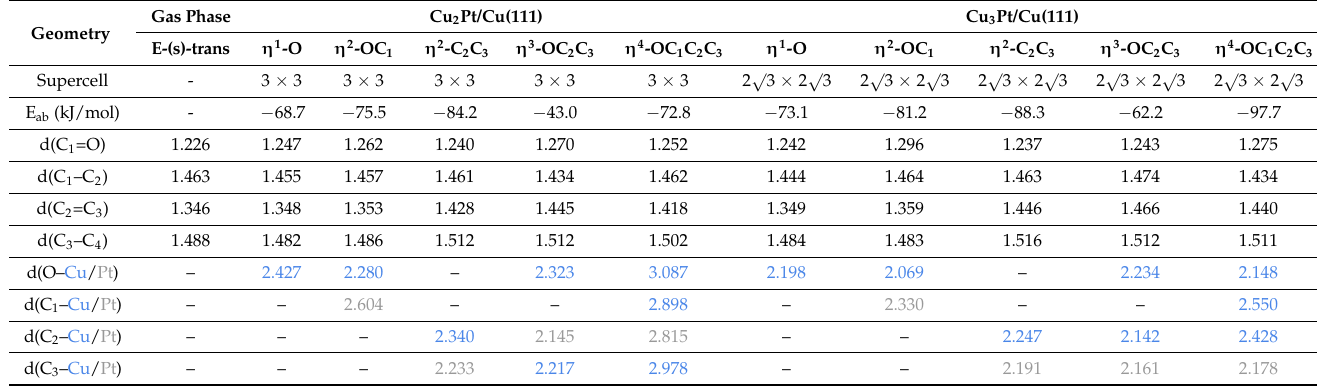
Table 2. Calculated bond lengths for the E-(s)-trans crotonaldehyde in the different configurations considered in this work. Values for bonding to either Cu or Pt are indicated by the color of the numbers, blue for Cu and grey for